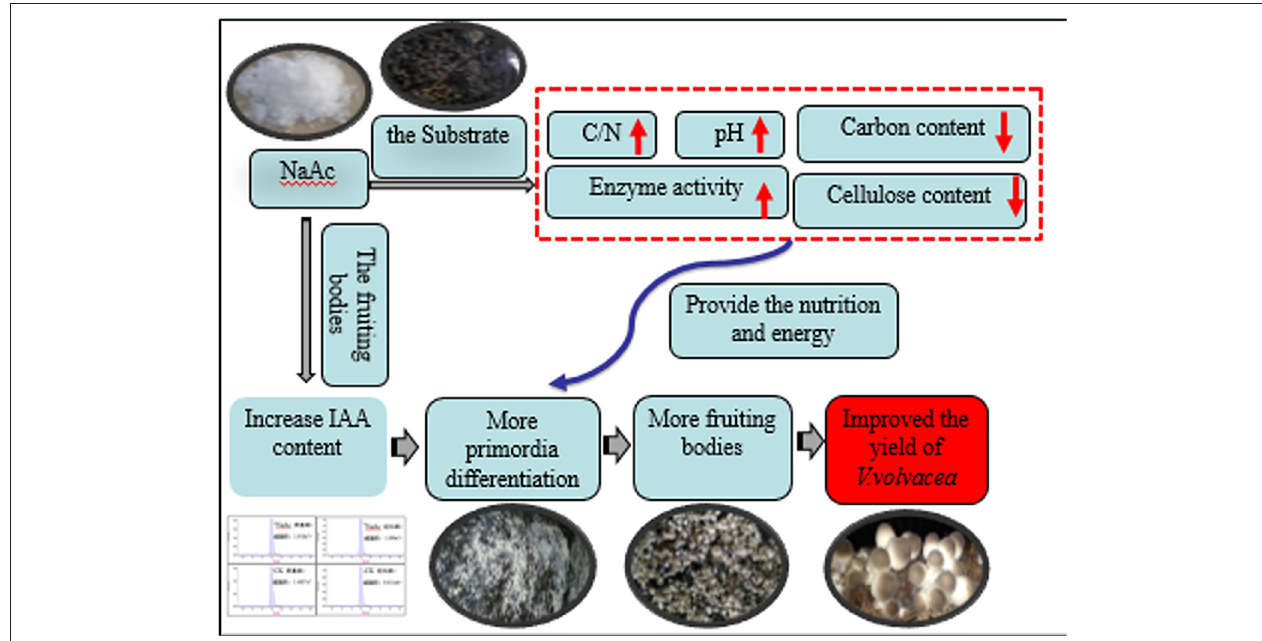
FIGURE 7 | Proposed biochemical mechanisms by which NaAc addition improved the mushroom